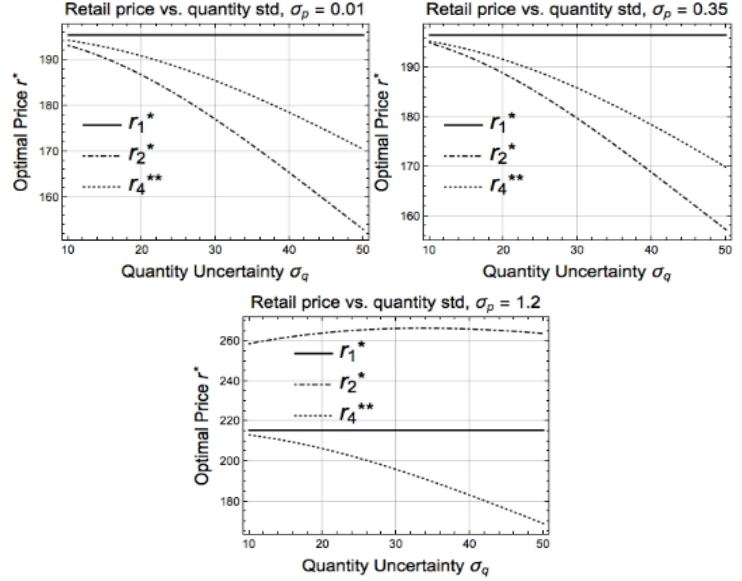
Figure 5. Comparison of r (cid:2869)∗ , 𝑟 (cid:2870)∗ , and 𝑟 (cid:2872)∗∗ as from Theorems 1, 2, and 4 as a function of quantity volatility σ (cid:2927) under small (top-left, σ (cid:2926) = 0.01 ), medium (top-right, σ (cid:3043) = 0.35 ), and large (bottom, σ q under small (top-left, σ p = 0.01 ), medium (top-right, σ p = 0.35 ), and large (bottom, σ p = 1.2 ) σ (cid:3043) = 1.2 ) price volatility. price volatility.